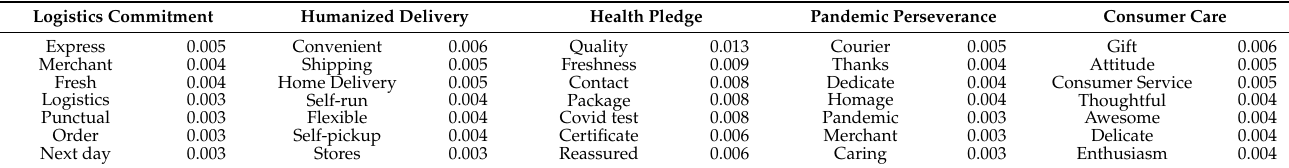
Table 4. Topic-word matrix of “e-commerce